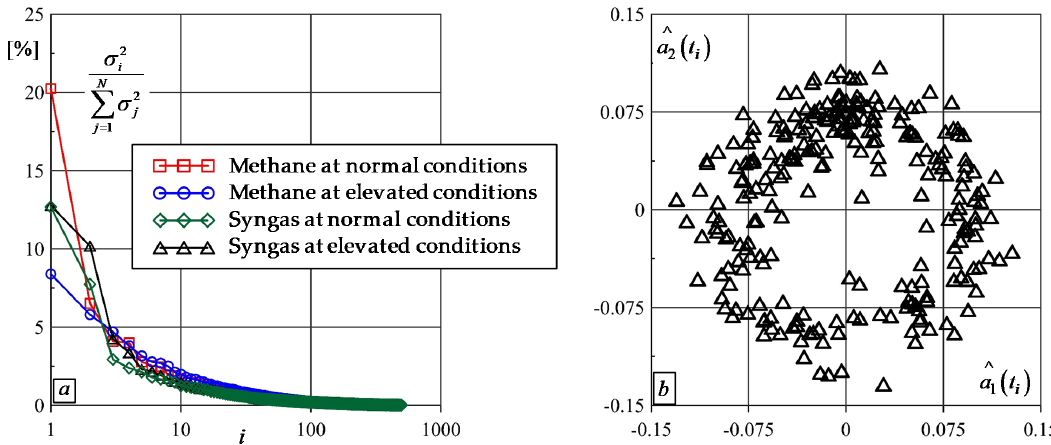
Figure 6. POD spectra of velocity fields ( a ) and temporal coefficients of the first two POD modes for the syngas flame at elevated pressure ( b ).